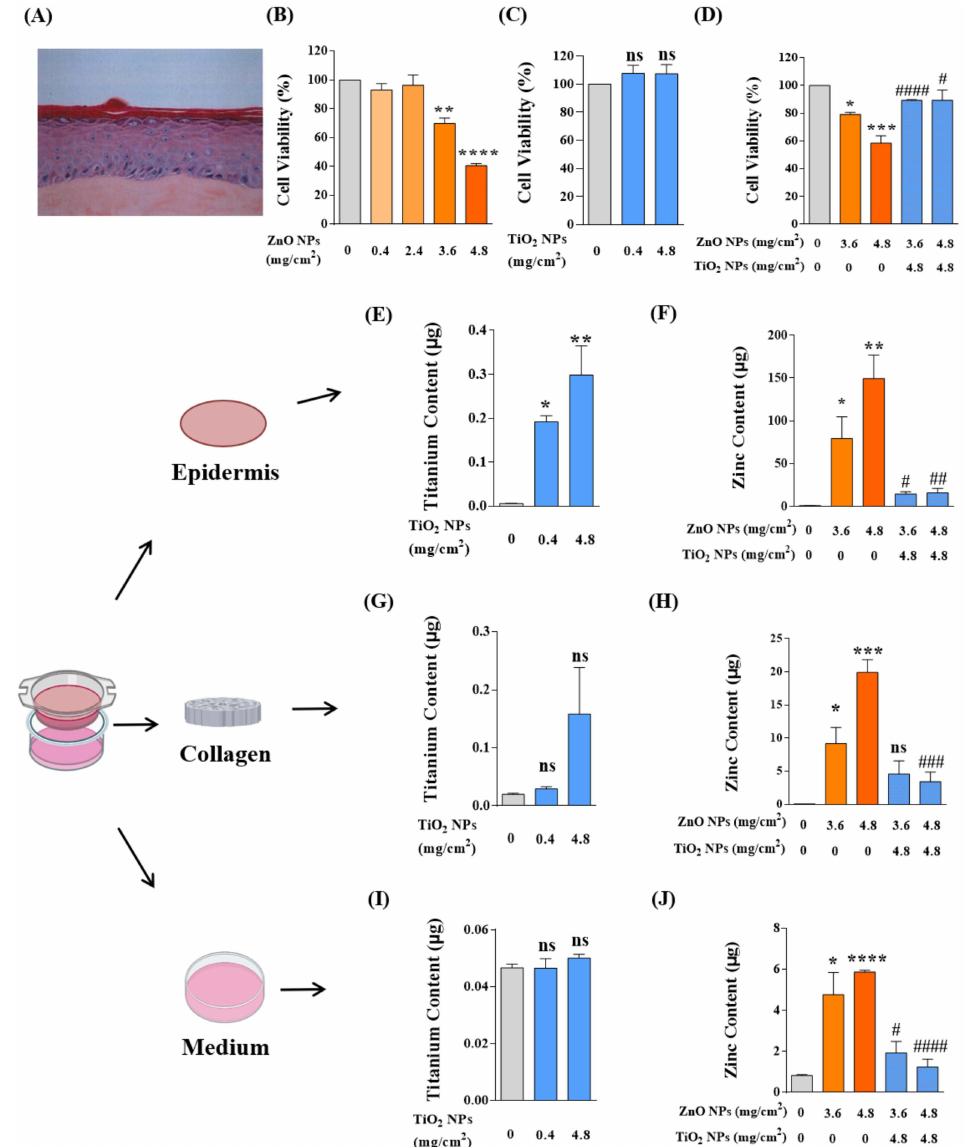
Figure 8. TiO 2 NP co-exposure reduced the dermal toxicity induced by ZnO NPs alone on the in vitro reconstructed human epidermis (RHE) EpiSkin. ( A ) The hematoxylin–eosin staining (HES) of paraffin sections of EpiSkin model. ( B , C ) The viability of basal cells from EpiSkin epidermis was